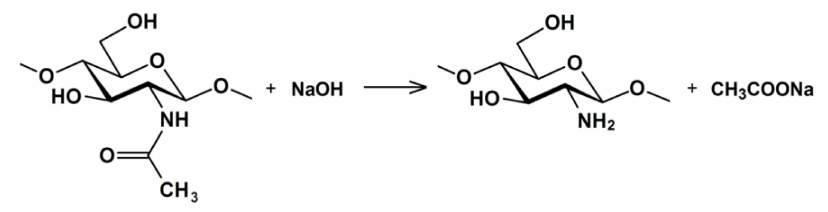
Figure 2. Reaction scheme for N-deacetylation of